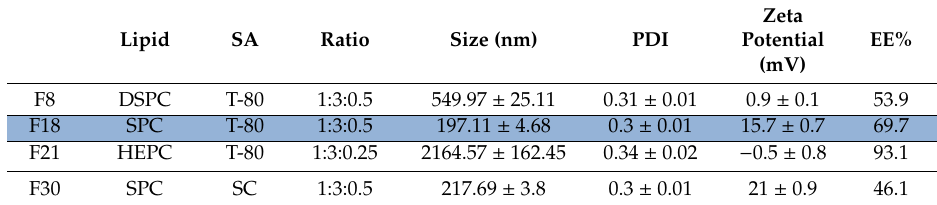
Table 2. Physical characteristics of the carvedilol-loaded